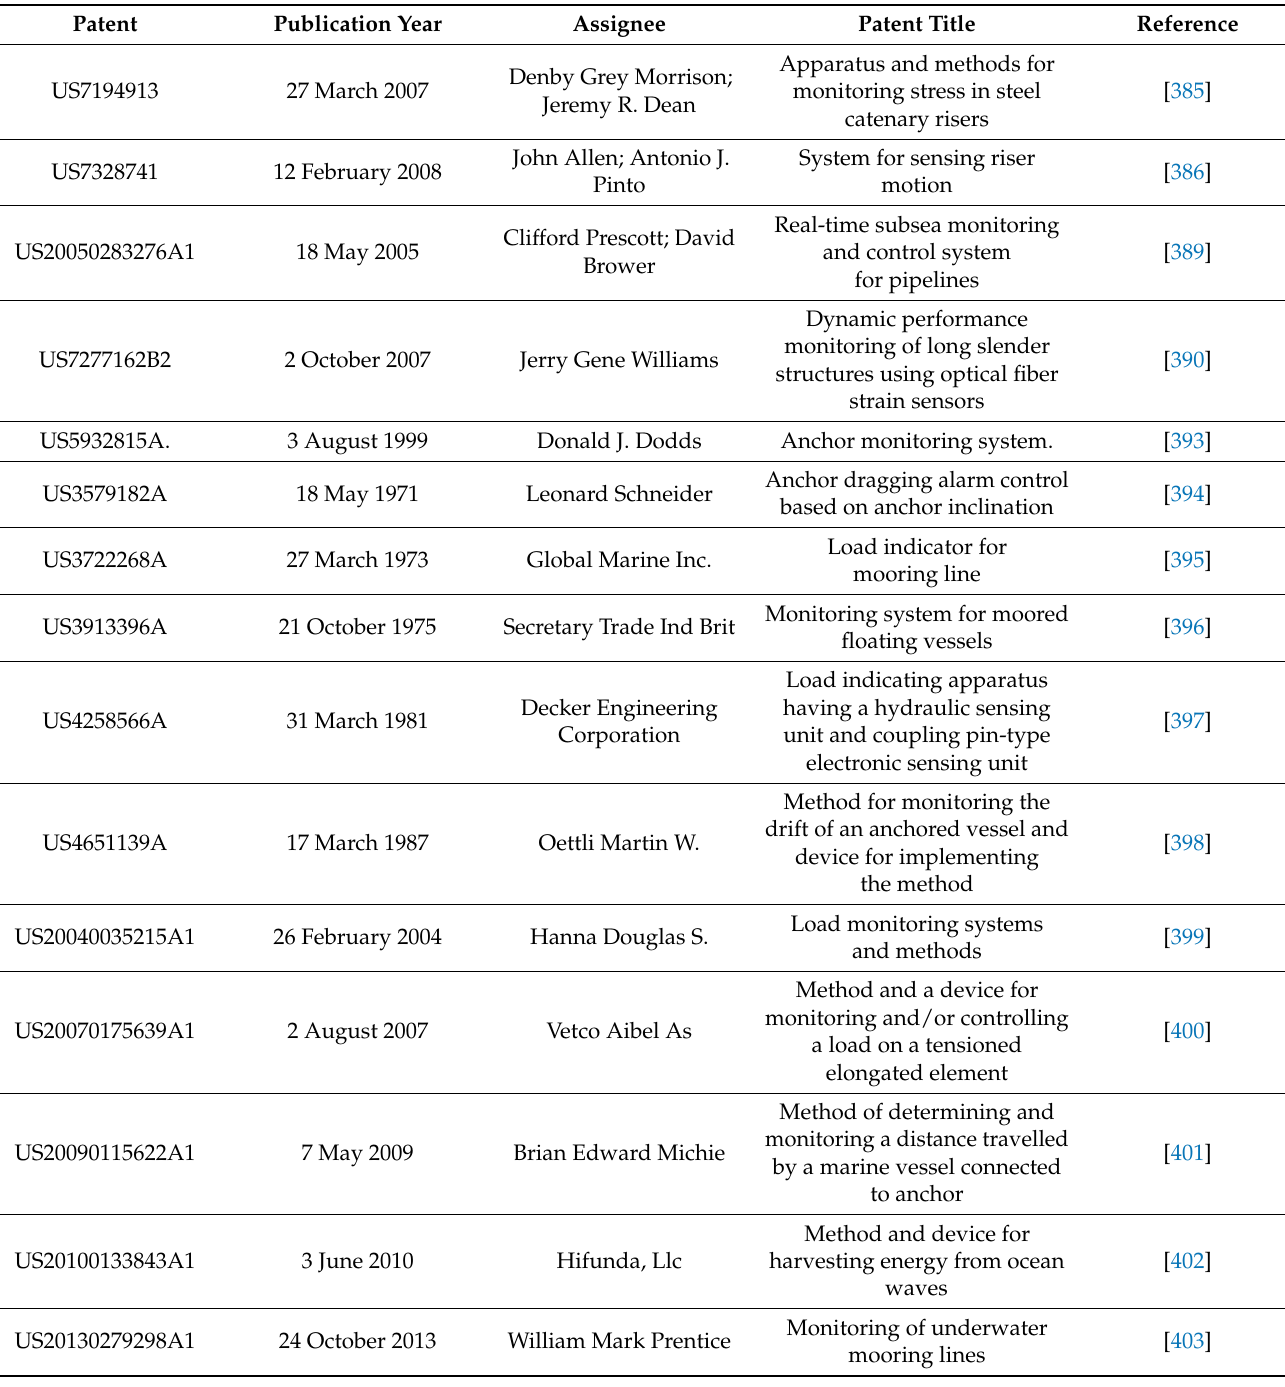
Table 4. Patents on offshore monitoring systems, asset management, and structural